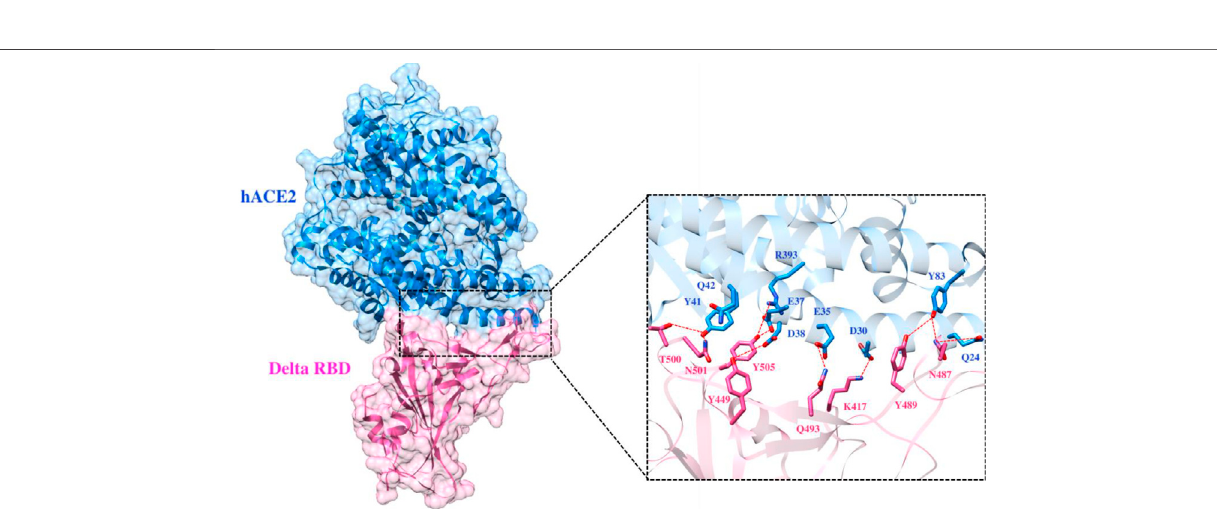
Frontiers in Chemistry |